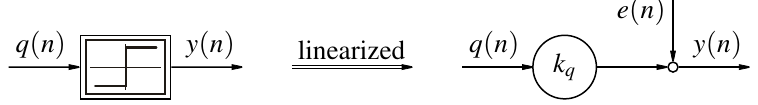
Figure 11. Linear model of the quantizer utilized in a ∆Σ -modulator comprised of a gain ( k q ) and a white noise source ( e ( n ) ) [17].